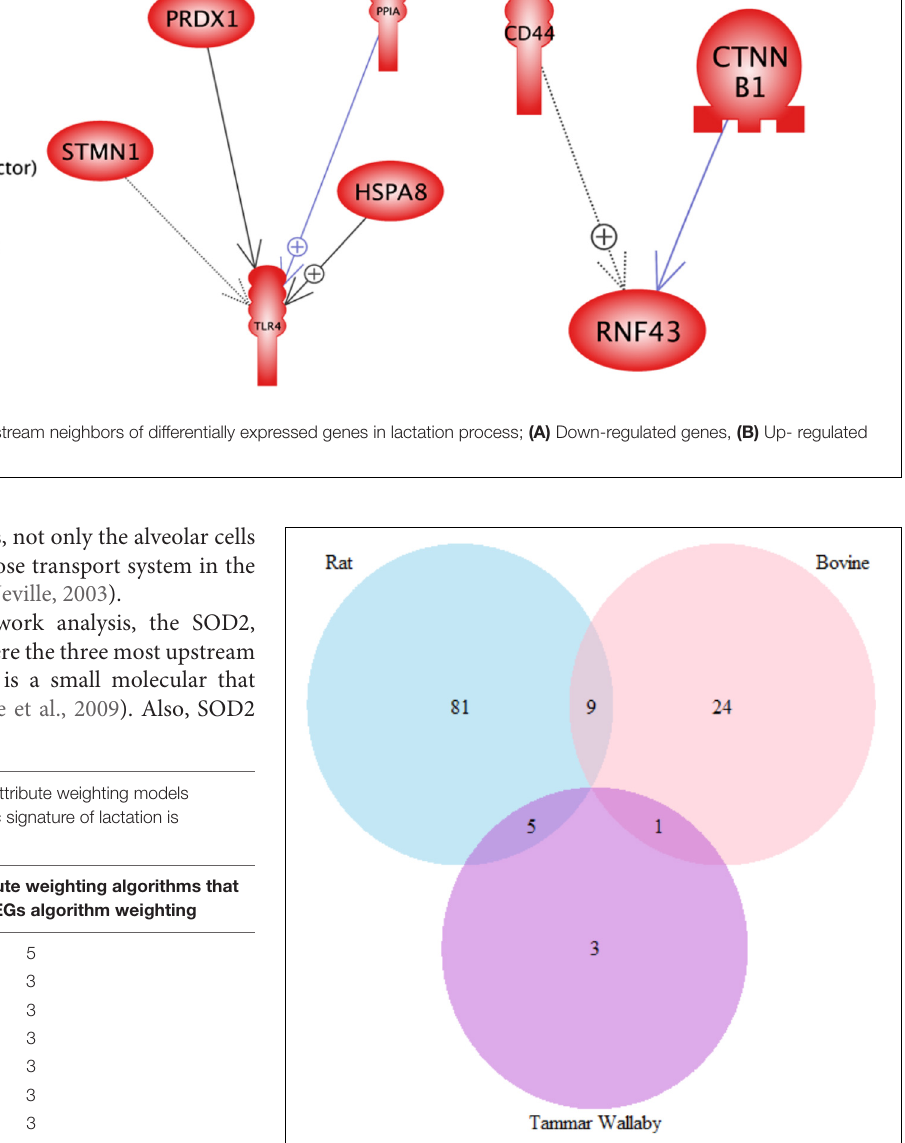
FIGURE 10 | Venn diagram representing the number of genes that were selected by more than three attribute weighting model in three species to differ in lactation